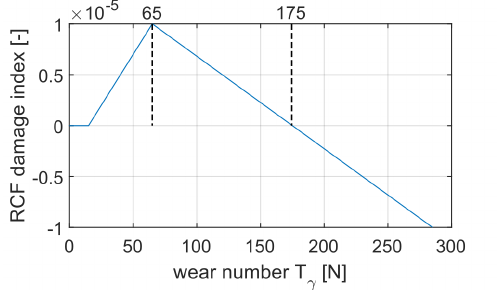
Figure 1. Dependence of the wear number T RCF damage index. [3]